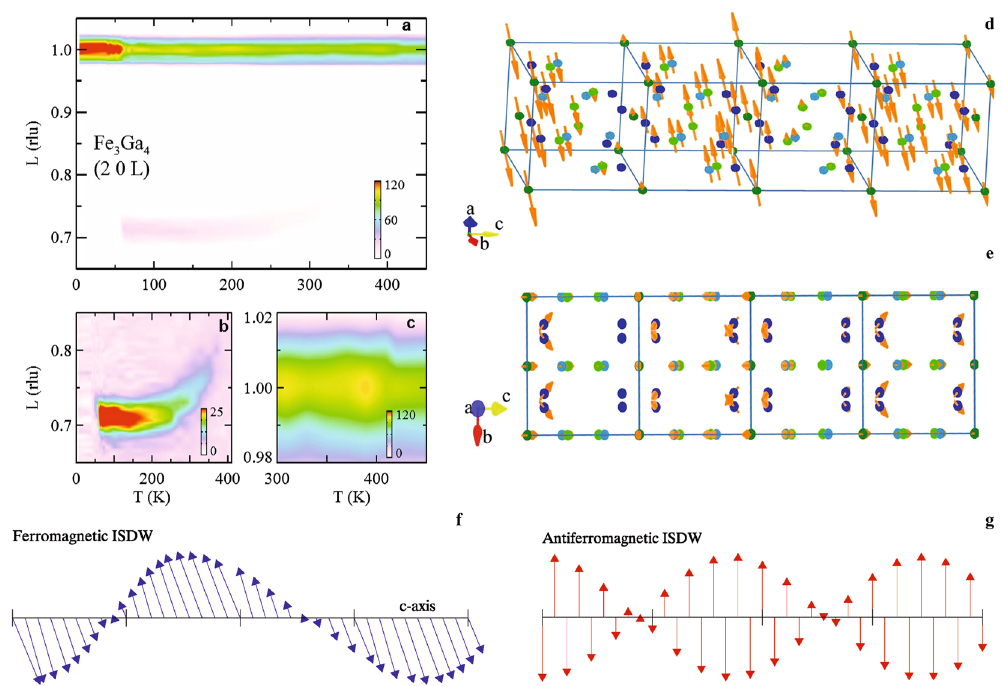
Figure 1. Neutron Diffraction. Temperature, T , dependence of the neutron scattering intensity along the (2 0 L ) direction. Scans were performed in increments in L of 0.005 reciprocal lattice units (rlu) for T 5 450 ≤ ≤ K in increments of 5 K. Color-bars indicate the scattering intensity in counts/s. Intensity plots displaying scattering ( a ) over the full q and T range of the data, ( b ) near the incommensurate wave-vector (2 0 1- δ ) for ≤ ≤ T 5 450 K, and ( c ) in proximity to (2 0 1) for T 300 450 ≤ ≤ K. ( d ) Magnetic structure at 100 K over a four unit cell length along the c -axis depicting the ISDW state. Solid circles represent the 4 different Fe sites within the Fe 3 Ga 4 unit cell. Structural data can be found in Supplementary Table S1. ( e ) Magnetic structure at 100 K viewed along the a -axis highlighting the non-collinear magnetic structure determined from the refinement of the neutron diffraction data. ( f ) Schematic of a modulated ferromagnetic ordering similar to the ISDW state in Fe 3 Ga 4 . The lattice constant is indicated by the tick marks and the tilting of the magnetic moments along the modulation direction ( c -axis) is representative of the ISDW state determined for Fe 3 Ga 4 . ( g ) Schematic of the more common ISDW state found in antiferromagnets such as